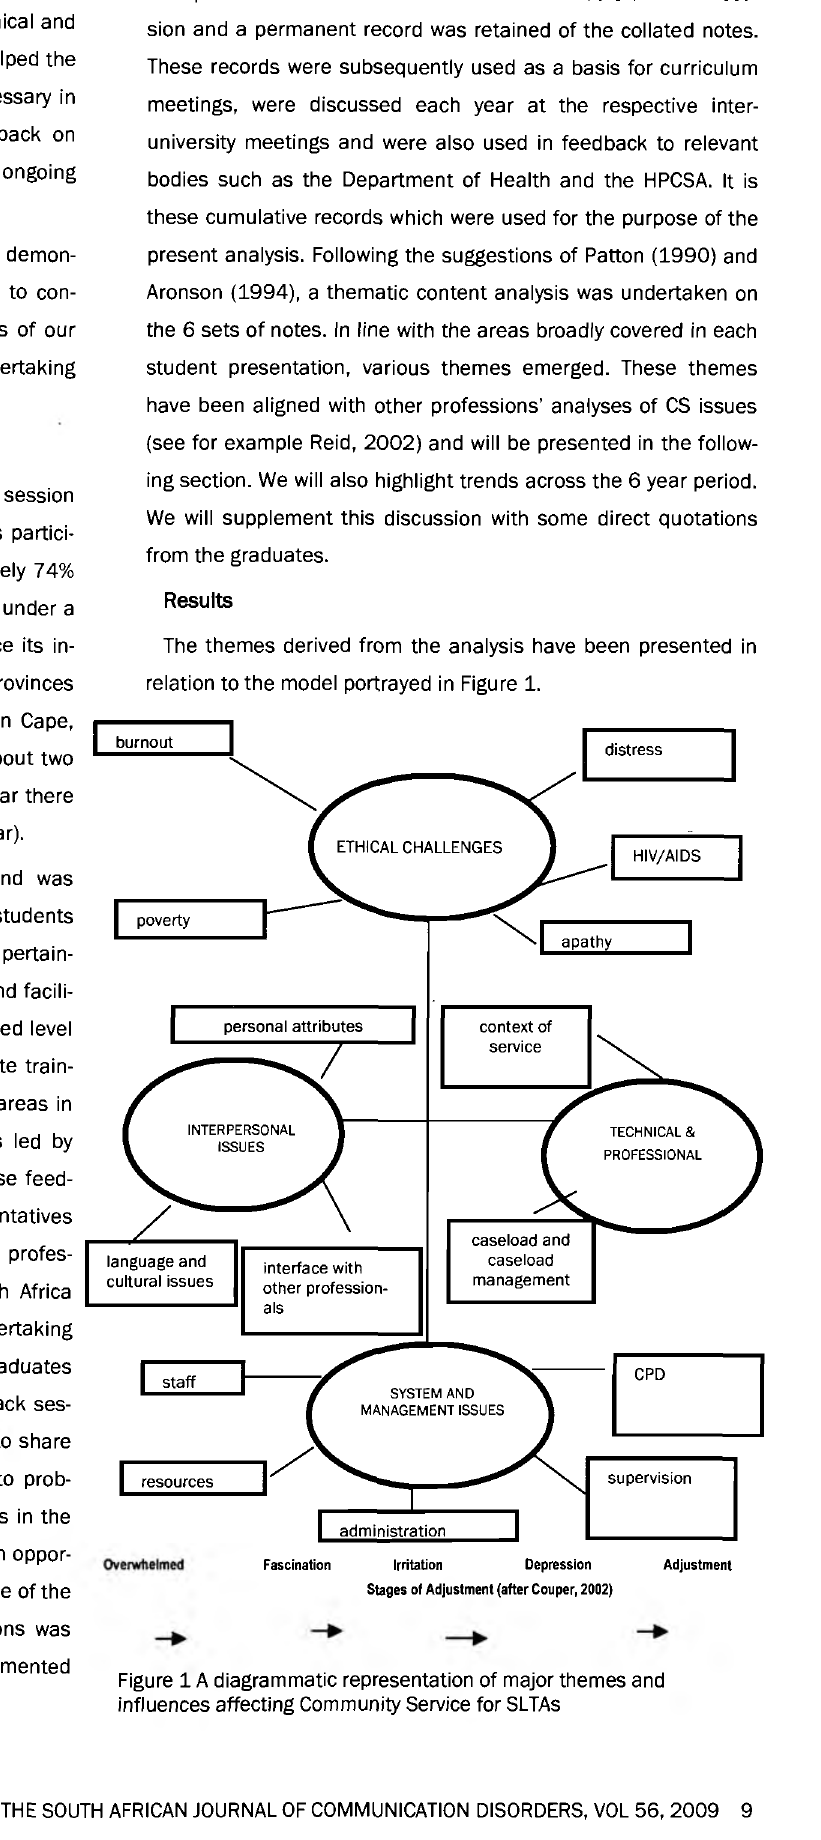
Figure 1 A diagrammatic representation of major themes and influences affecting Community Service for SLTAs